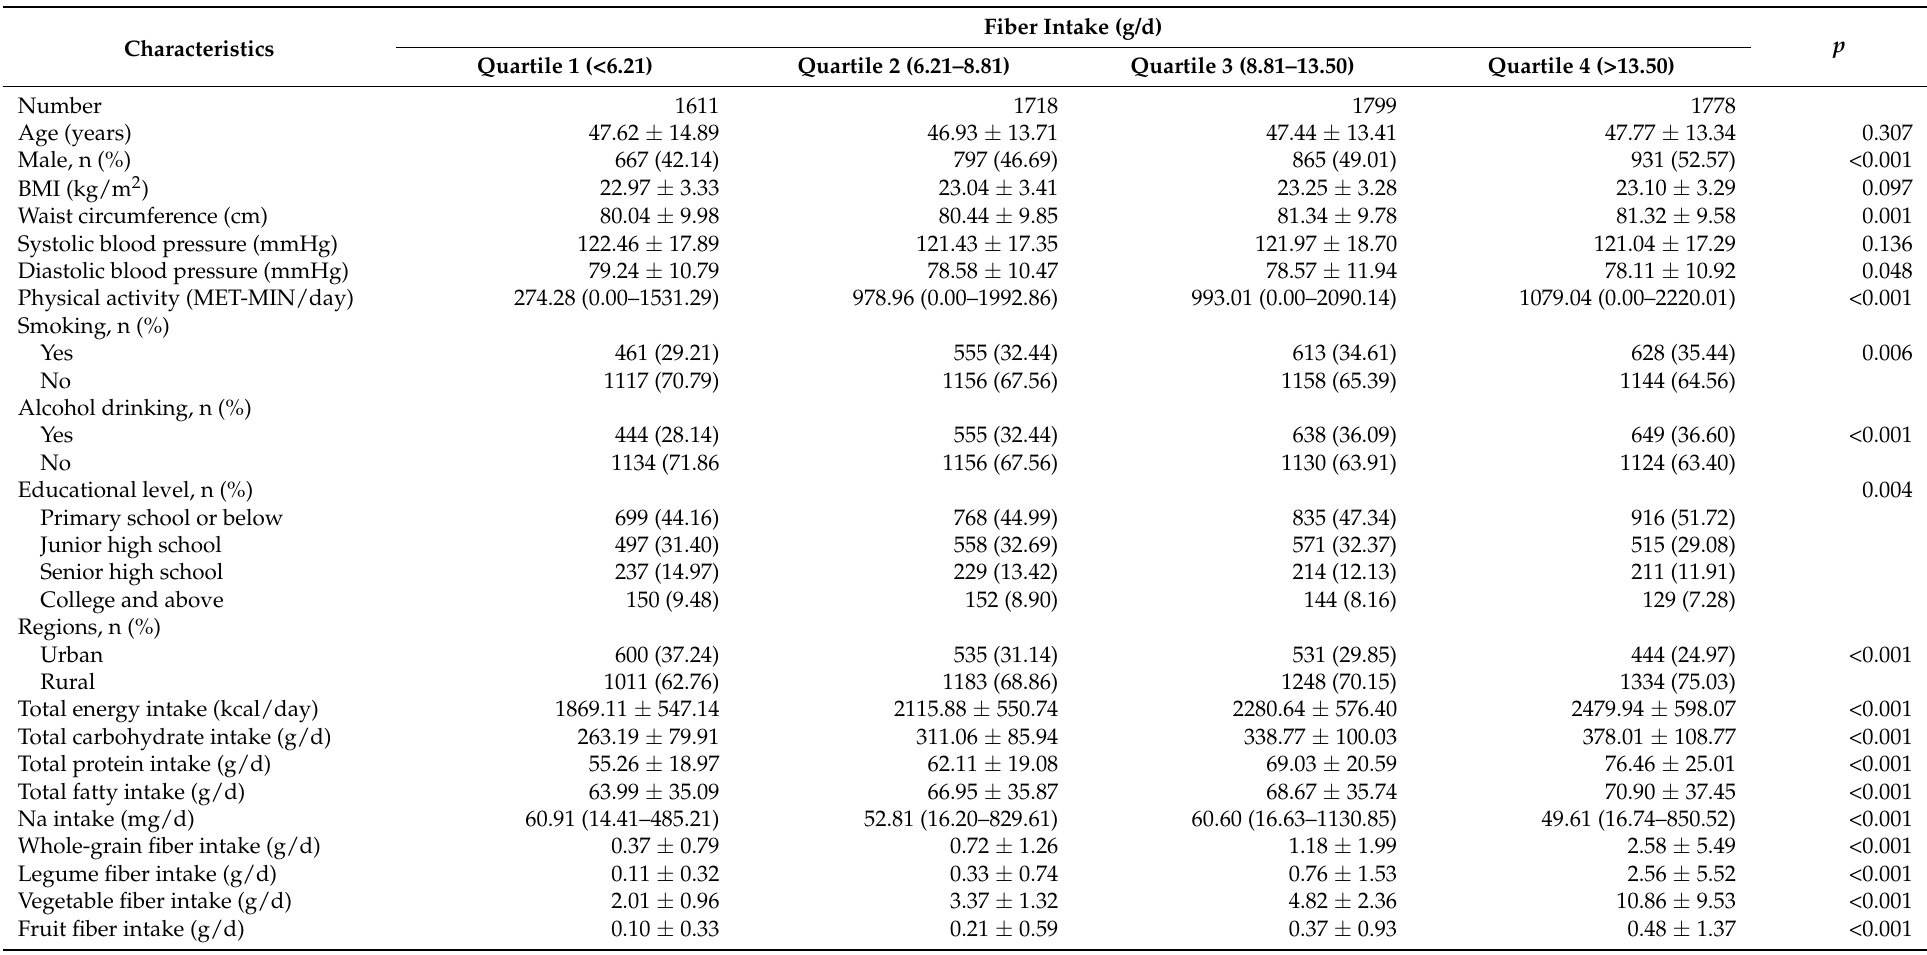
Table 1. Characteristics of the study population at inclusion in the T2D cohort, according to quartiles of total dietary fiber intakes.